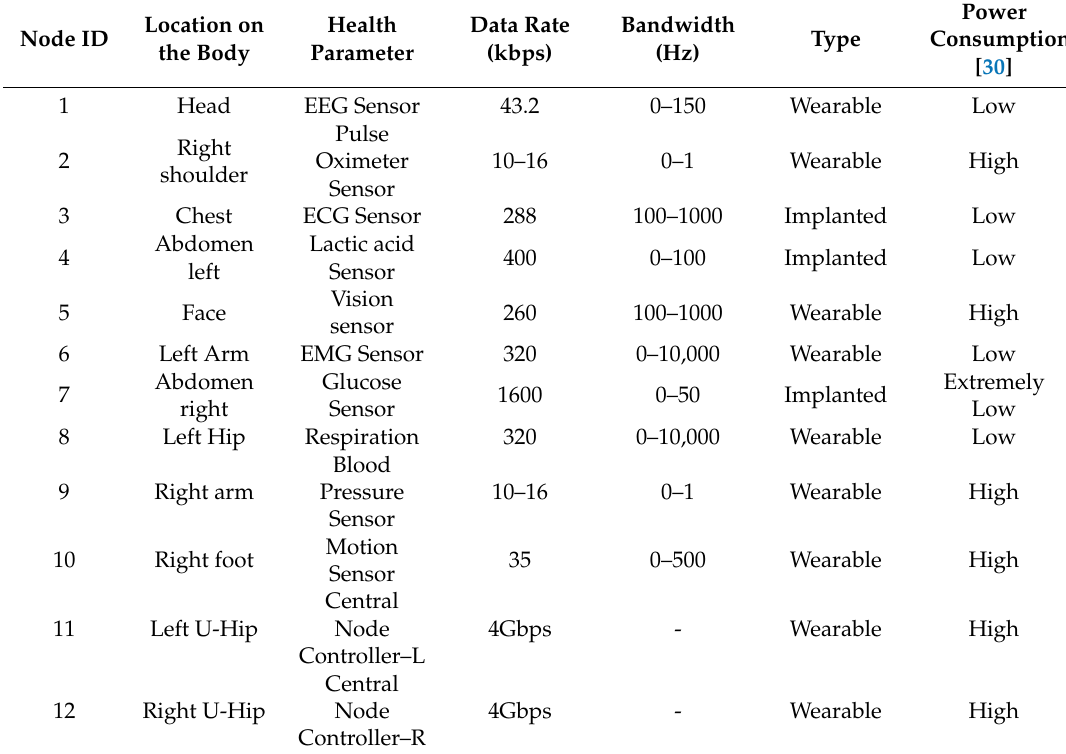
Table 2. Biological SNs details with SNs IDs